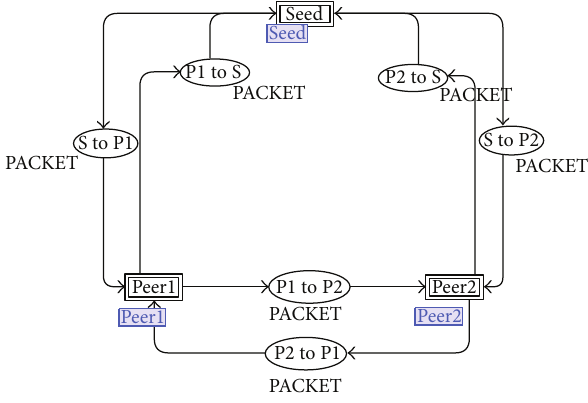
Figure 9: The top page of the BT software